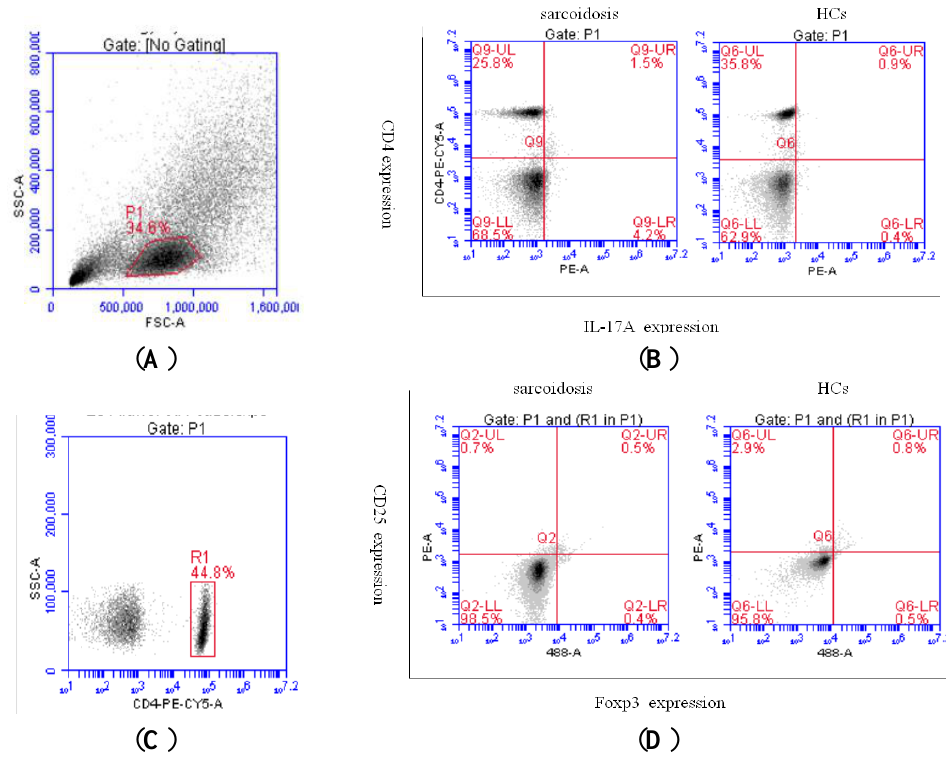
Figure 1. Representative plots of Th17 and Treg cells in sarcoidosis patients’ and HCs’ peripheral blood by flow cytometry ( A , B , C , D ). ( A ) Physical parameter (forward scatter and side scatter) of lymphocytes in the peripheral blood; ( B ) Representative dot plots showing CD4 + T cells producing IL-17A in sarcoidosis patients’ and HCs’ peripheral blood; ( C ) Physical parameter (side scatter) and CD4 expression of lymphocytes in the peripheral blood; ( D ) Representative dot plots showing CD4 + T cells producing CD25 and Foxp3 in sarcoidosis patients’ and HCs’ peripheral blood.